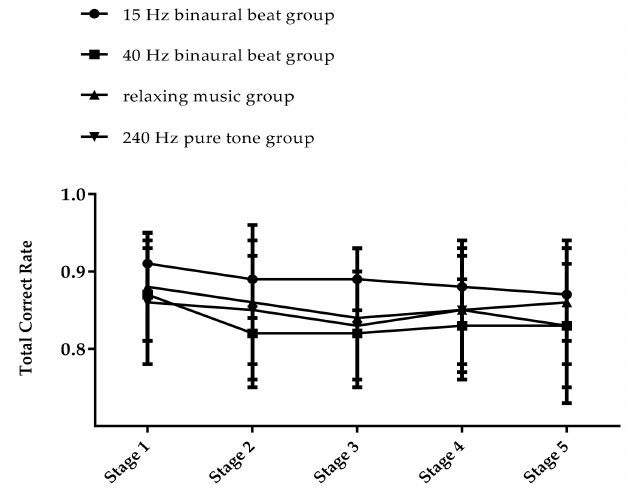
Figure 5. The trend in total accuracy rate of TloadDback (%).